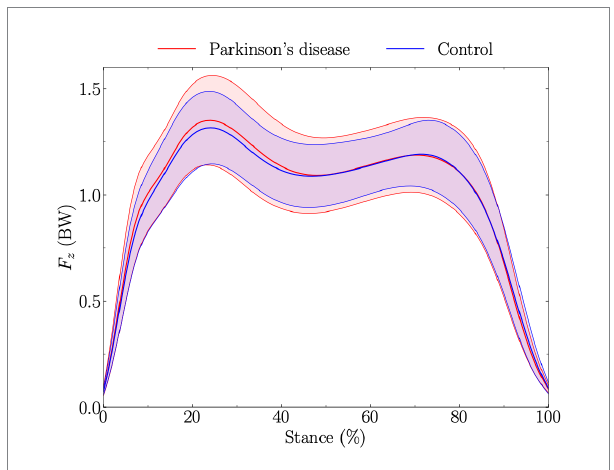
FIGURE 1 Vertical ground reaction force corresponding to a single foot ( F z ), expressed in body weight (BW), during stance (from foot-strike to toe-off of the same foot). Solid red and blue lines represent the average for Parkinson’s disease and control groups, respectively, while the standard deviations are given by the shaded areas. The t -test comparing Parkinson’s disease and control groups along the walking stance phase and obtained using statistical parametric mapping was not significantly different.